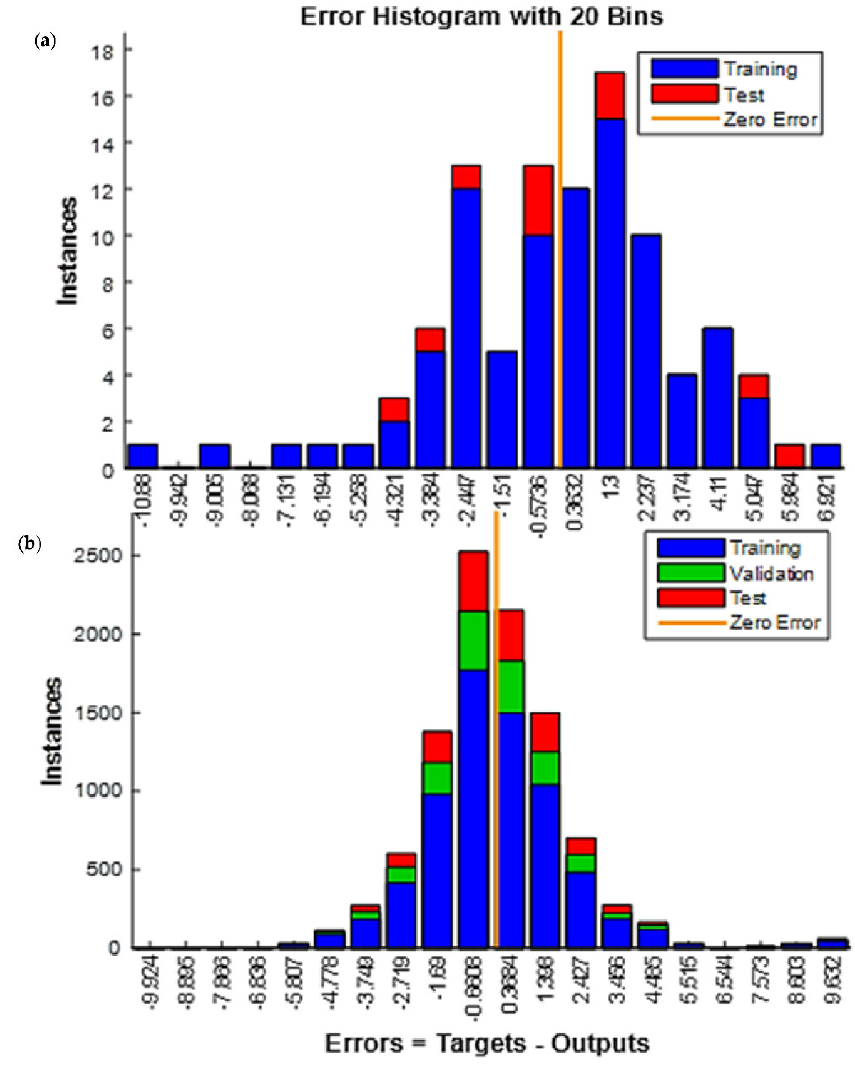
Figure 6. ( a ) A training performance of 9.6461 with 100 Samples, ( b ) a training performance of 4.1030 with 10,000 Samples.